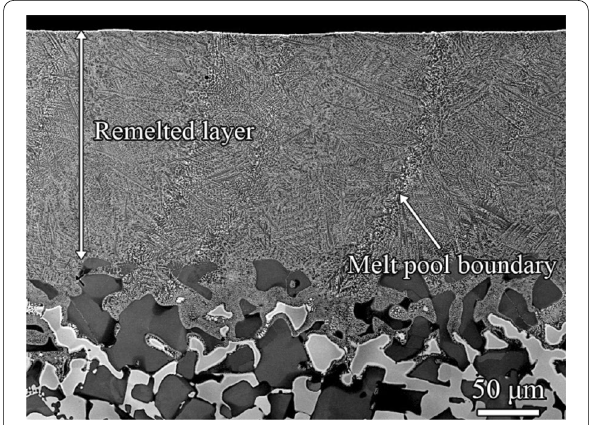
Figure 3 BSE image of the remelted layer produced on the hypereutectic Nb-Si based alloy via EBSM